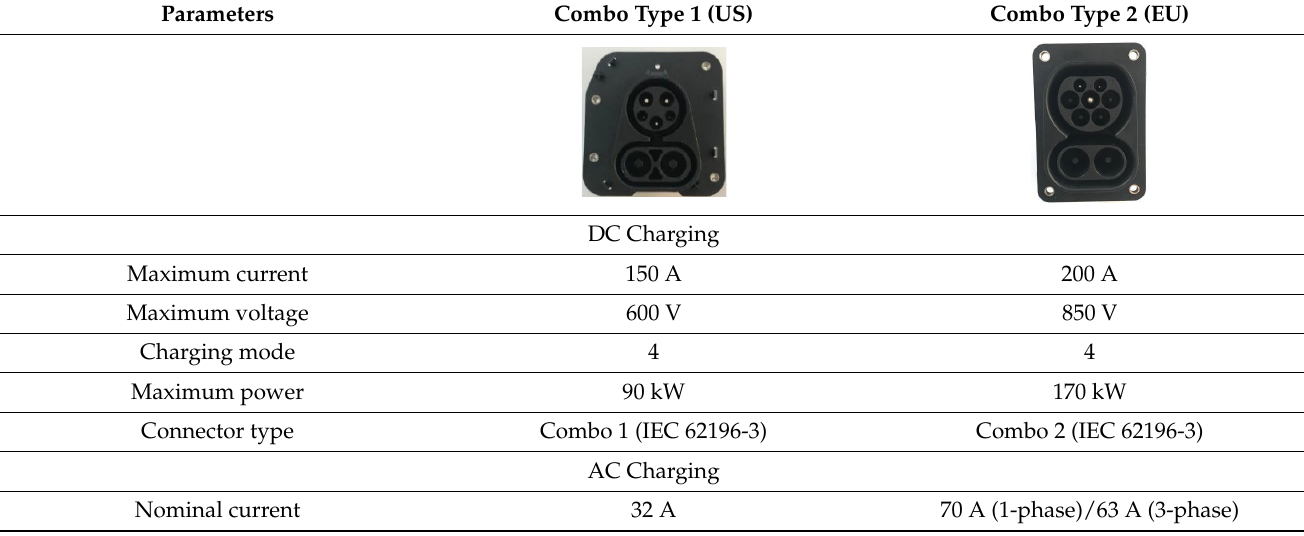
Table 5. Main characteristics of Combo connectors Type 1 and type 2 [31].